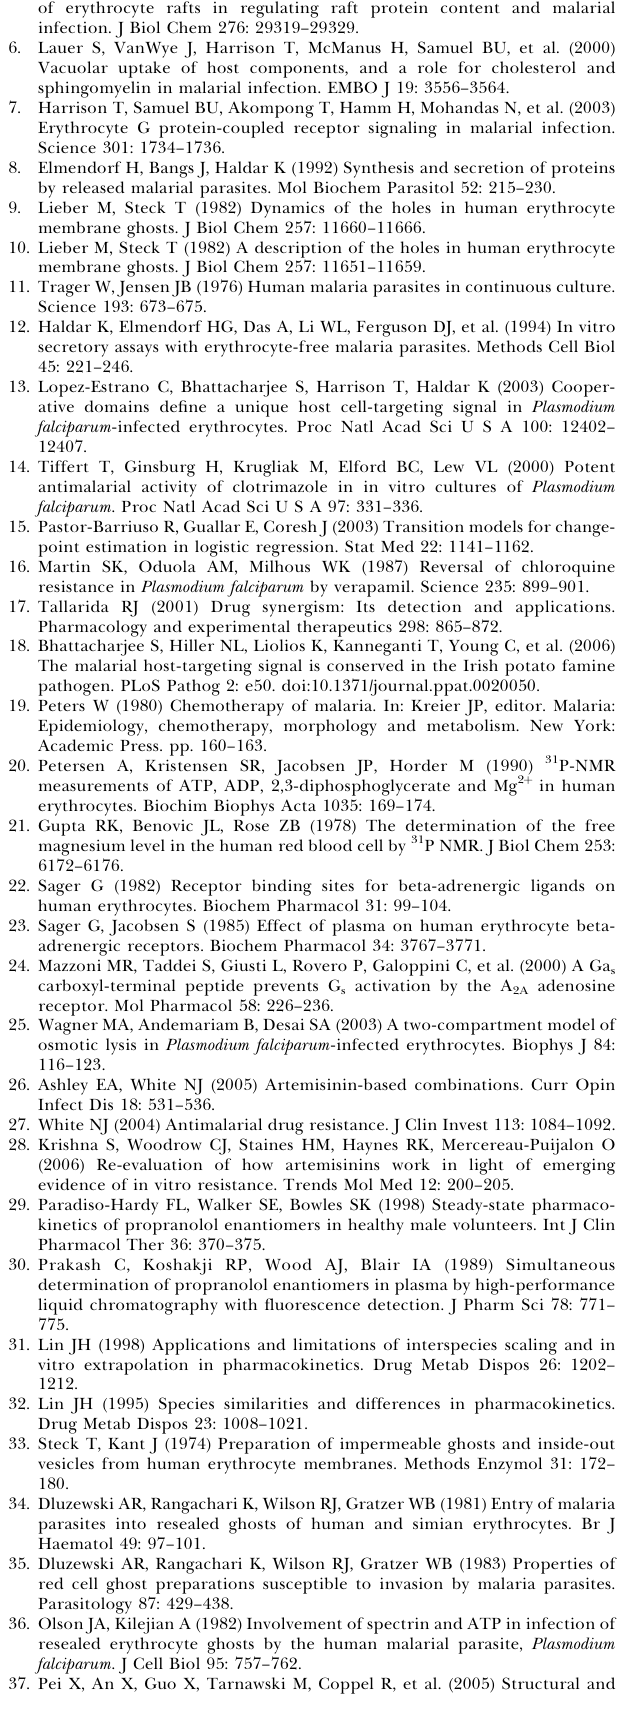
Figure S1. G i - and G q -Specific Peptides Do Not Inhibit Malarial Invasion of Ghosts Erythrocyte ghosts were incubated with 50 l M control G scr , G s , G i , or G q peptides and tested for invasion as described in Methods. Error bars show standard deviations across three experiments in triplicate. Figure S2. [ 3 H]-Hypoxanthine Assays to Determine In Vitro IC 50 Values of Individual Drugs Used in This Study IC 50 s for each drug were determined in chloroquine-sensitive (3D7) and chloroquine-resistant (FCB) P. falciparum by in vitro [ 3 H]- hypoxanthine incorporation (see Methods). IC 50 values were deter- mined by fitting the data as described in Methods; each data point is shown in triplicate. Asterisks denote p , 0.05; hash marks denote p , 0.01; crosses denote p , 0.001. CQ, chloroquine; Art, artemisinin; Prop, propranolol. Figure S3. Propranolol Functions Additively with Existing Antima- larials In Vitro and In Vivo Isobolograms (see Methods) are presented for in vitro studies of propranolol and chloroquine ([A], in 3D7 strain; [B], in FCB strain) and propranolol and artemisinin ([C], in 3D7 strain), and an in vivo study of propranolol and chloroquine in the P. berghei ANKA mouse model of malarial infection (D). Table S1. Effects of Propranolol-Containing Drug Combinations on Growth of P. falciparum and P. berghei Found at doi:10.1371/journal.pmed.0030528.st001 (20 KB